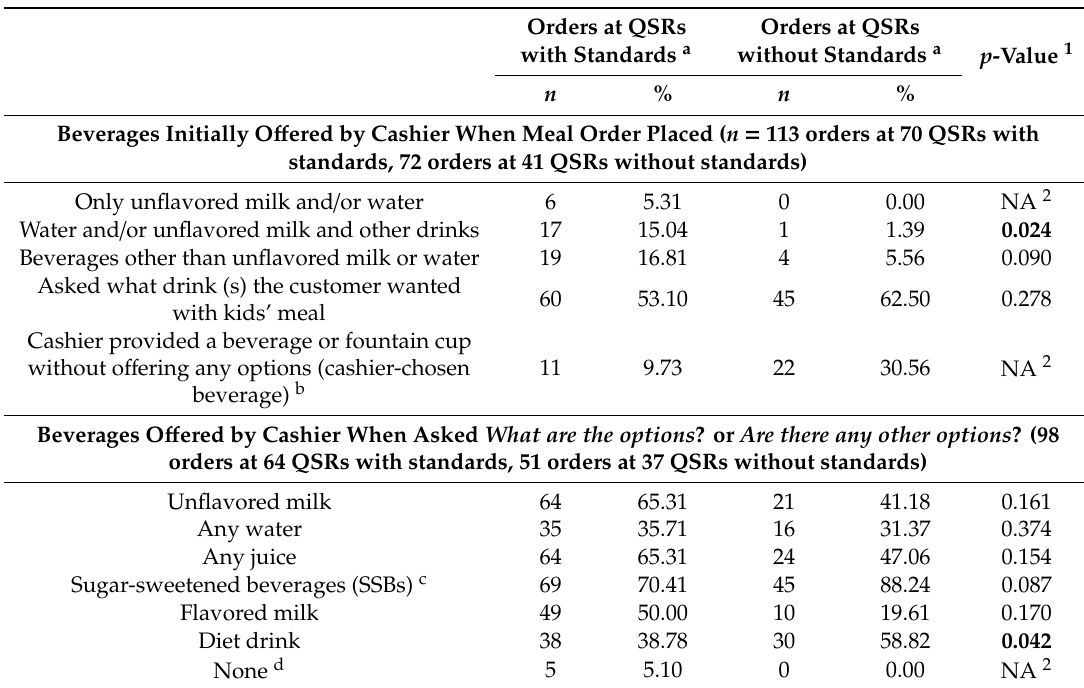
Table 3. Beverages o ff ered by cashiers during research sta ff kids’ meal orders at quick-service restaurants (QSRs; N = 185 orders).